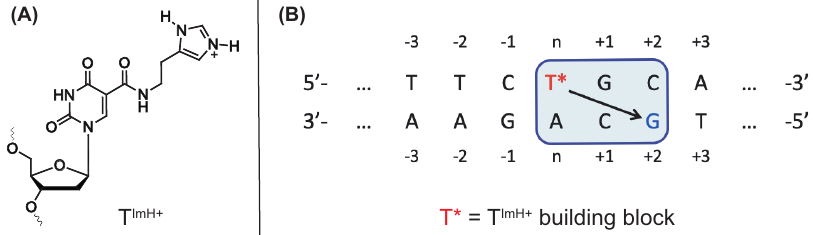
Figure 9. Structure of the T ImH + building block ( A ) and example of the ‘stabilizing motif’ in a DNA duplex ( B ) with T* being the T ImH + building block. The arrow indicates which guanine is involved via its Hoogsteen side in stabilizing hydrogen bonding with the imidazolium